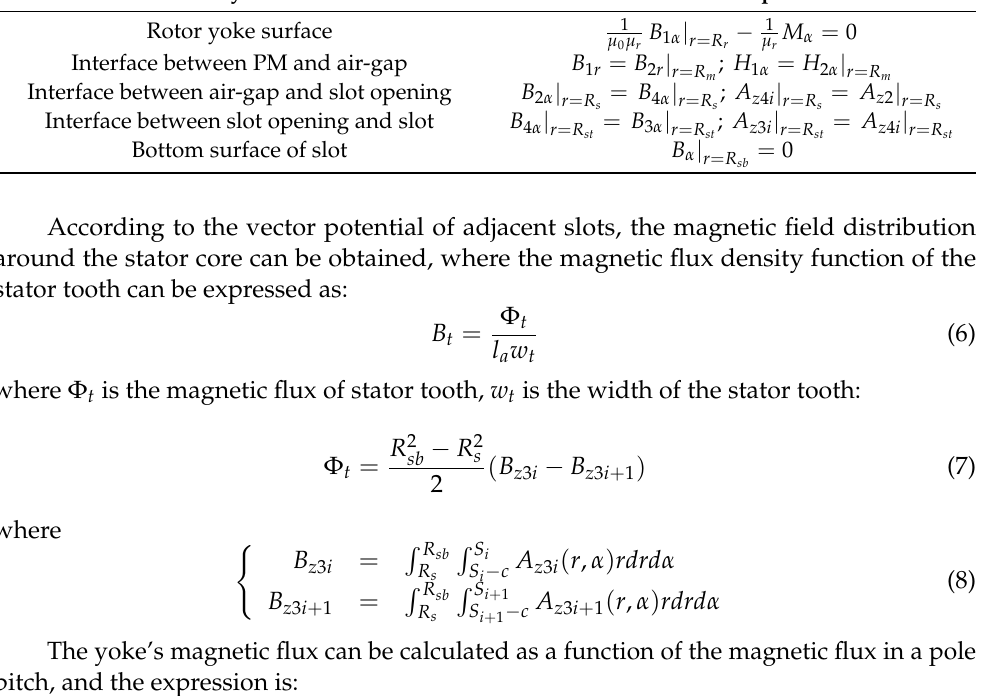
Table 2. Interface conditions between different subdomains.